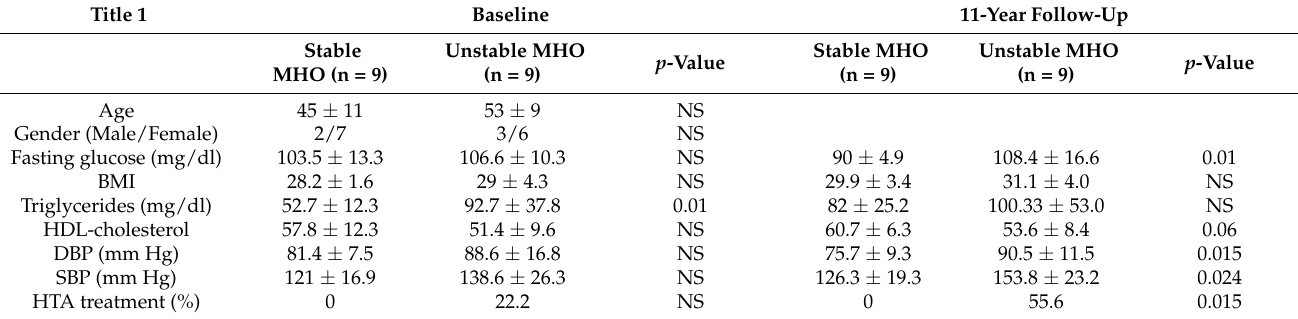
Table 1. Anthropometric and biochemical characteristics of the subjects included in the study.